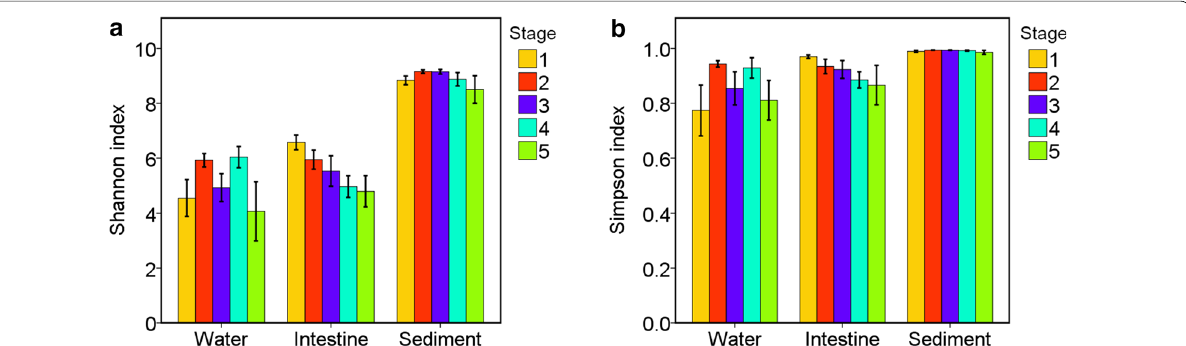
Fig. 2 The α -diversity comparison among three habitats. a The Shannon index b The Chao1 index. Compared to water and intestine samples, the α -diversity of sediment microbiota was the highest